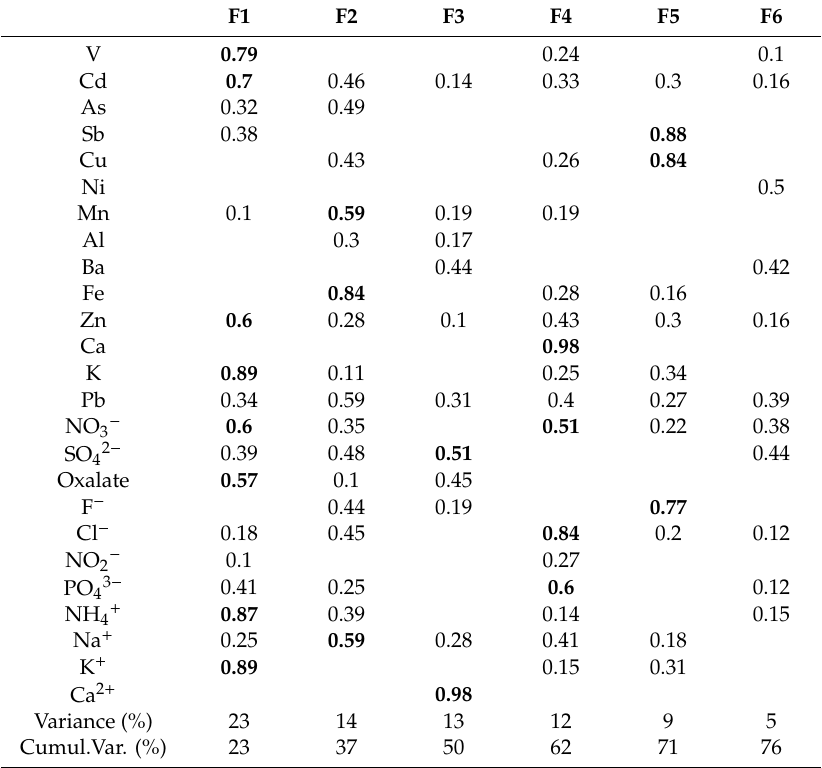
Table 6. Principal component analysis results of PM 1 components in Šlapanice.